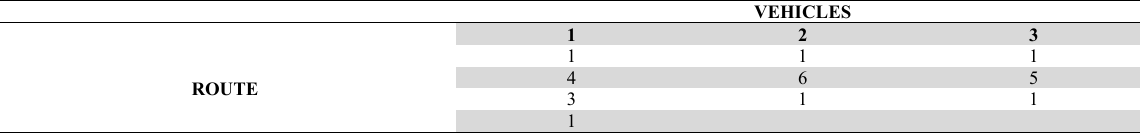
Example of route matrix. Own